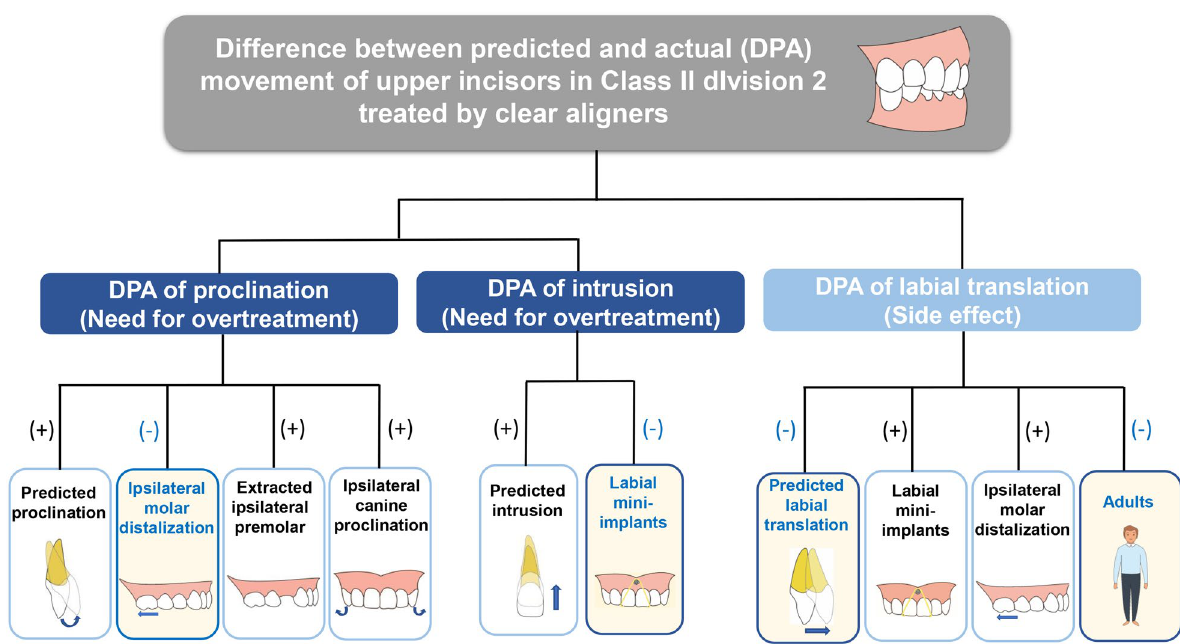
Fig. 6 The influencing factors for effectiveness of tooth movement in Class II division 2